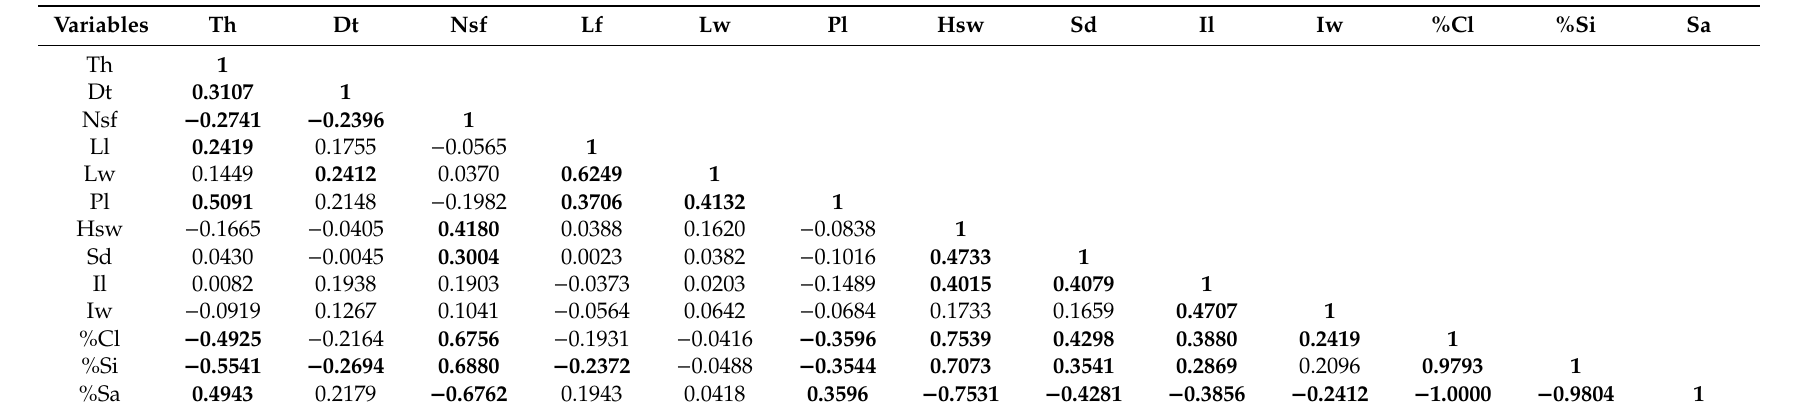
Table 7. Correlation between morphological traits and physical parameters of